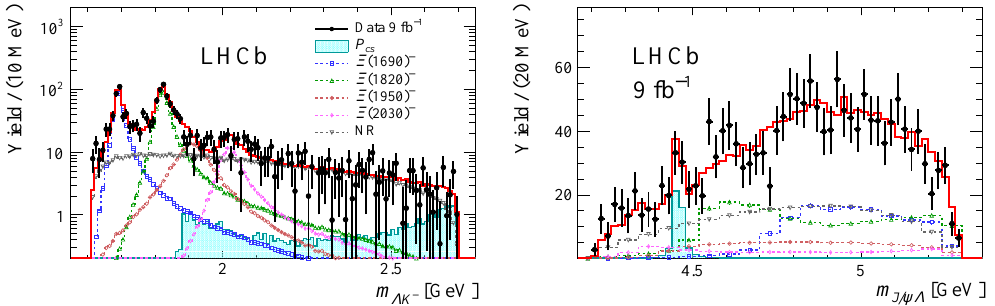
Figure 5: The left plot shows the fit to the Λ K − mass spectrum and the right to the J /ψ Λ spectrum respectively. Contributions from various Ξ − states are shown with coloured lines, as well as the contribution from the P area. The total fit is represented by the solid red